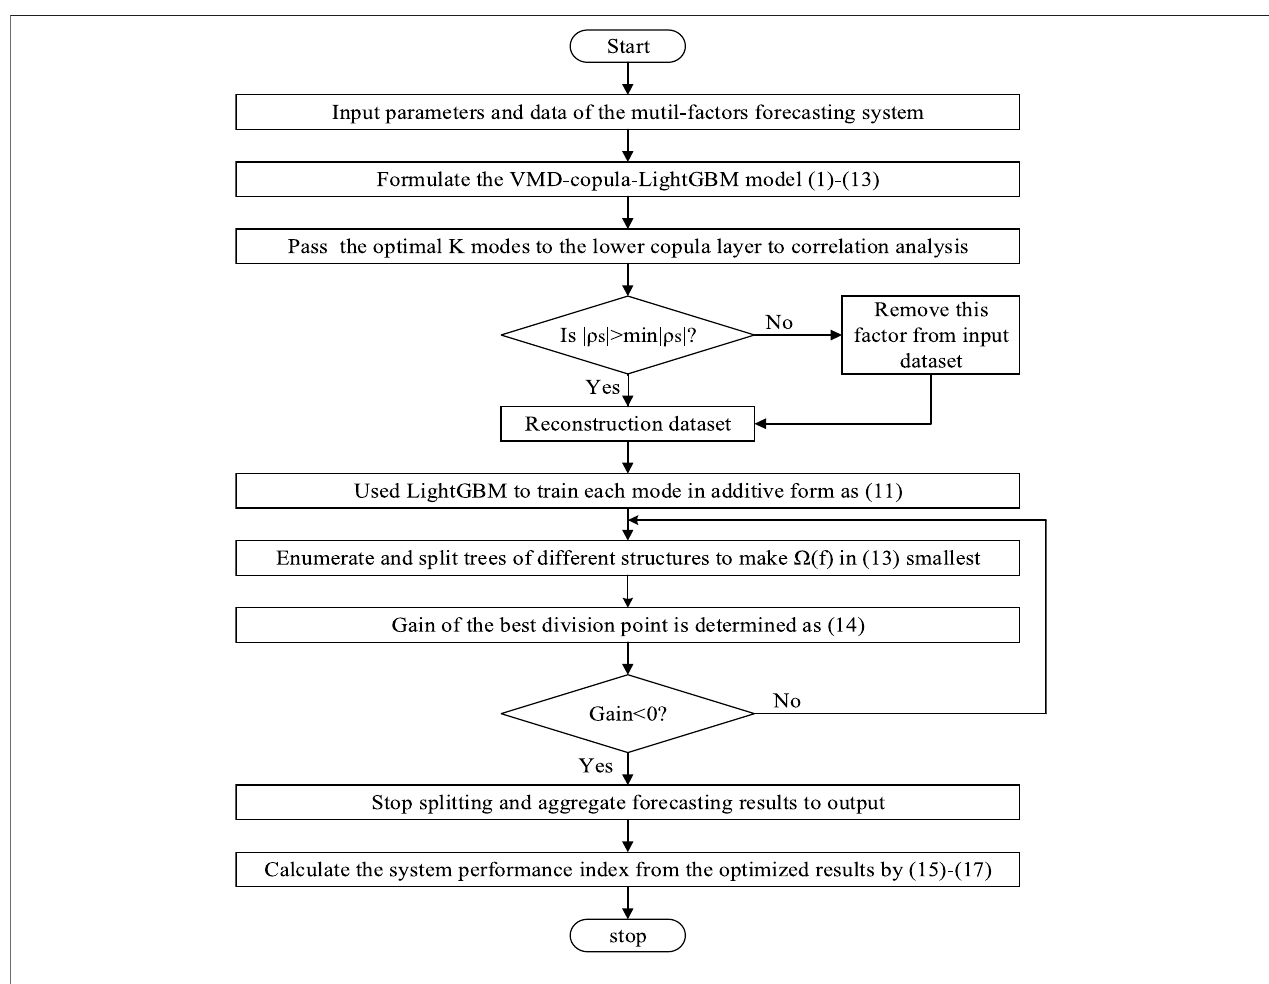
FIGURE 1 | Temporal-spatial load forecasting